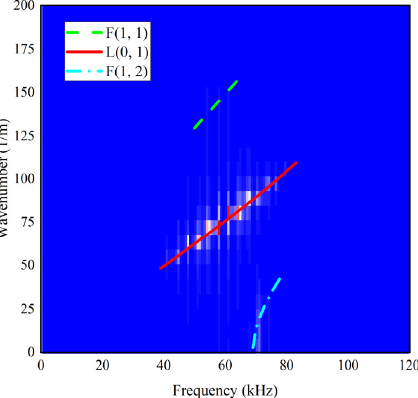
Figure 10. Wavenumber diagram based on 2D Fourier transform at 60 kHz.